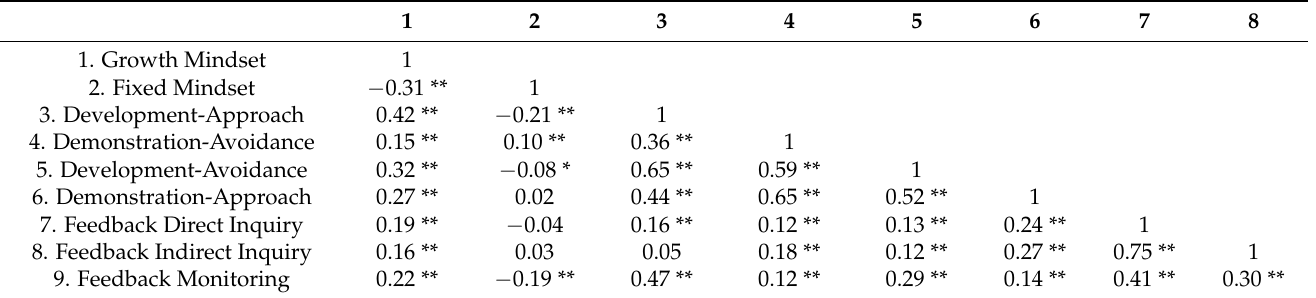
Table 2. Intercorrelations Among Predictors and Outcome Variables.